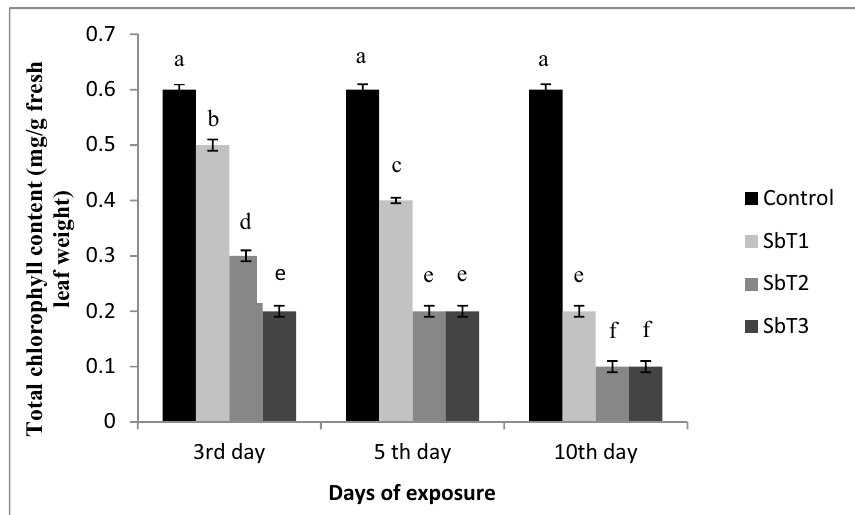
Figure 2. Graphical representation of total chlorophyll content in T. natans . Vertical bars represent standard deviation in total chlorophyll content at different initial concentrations. Different letters represent statistically significant differences at P < 0.05 from one-way ANOVA and post hoc test (Tukey HSD).